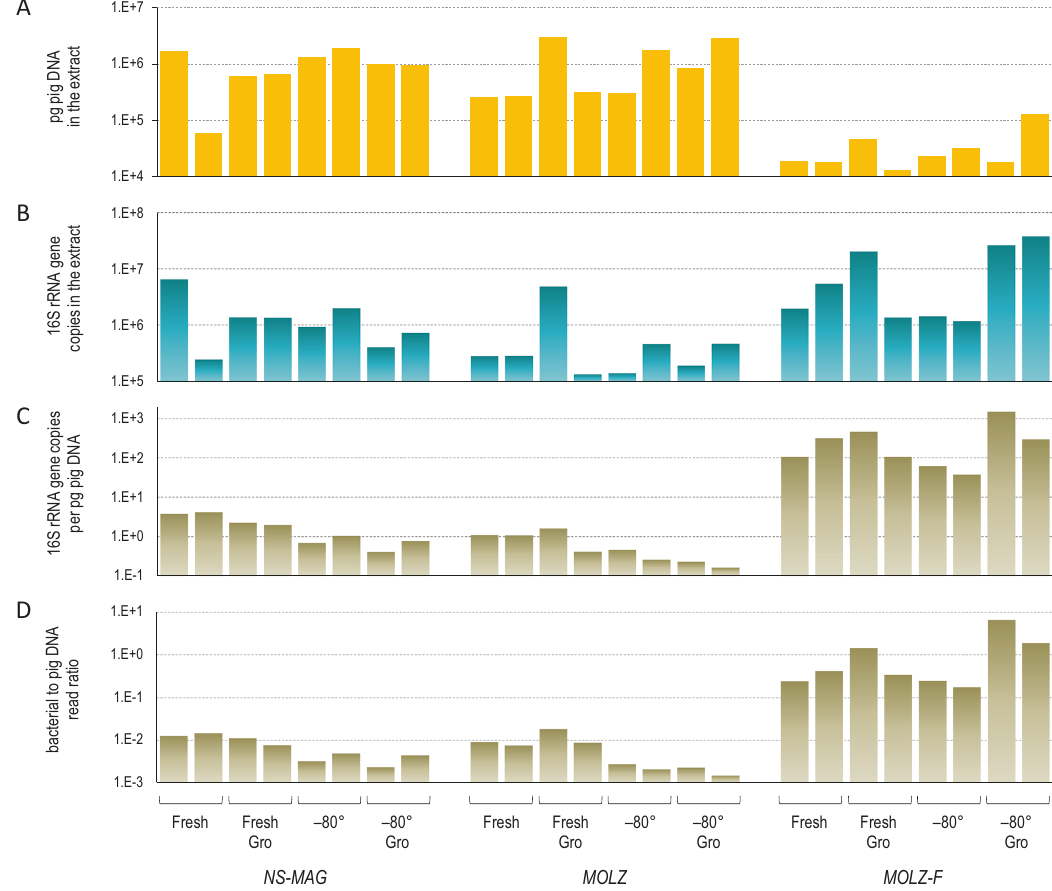
Fig. 1 Quanti fi cation of pig and bacterial DNA in NS-MAG , MOLZ and MOLZ-F extracts obtained from samples following four storage conditions. A Pig DNA quanti fi ed by qPCR. B Bacterial 16S rRNA gene copy number quanti fi ed by qPCR. C Bacterial 16S rRNA gene copy number (as in B ) normalized per pig DNA mass (as in A ). D Ratio of bacterial-to-pig sequencing reads in the mNGS dataset. The number of read pairs corresponding to pig genome was identi fi ed by CLARK. For bacteria, we calculated the average for the number of forward and reverse reads mapped by USEARCH to genome sequence assemblies of the four mock-community alignment-based approach (Fig. 3) but some drawbacks of the k-mer based fast-processing were identi fi ed. A substantial fraction of reads in NS-MAG and MOLZ samples was assigned to species different from those that constituted the mock community, notably Nesterenkonia natronophila (phylum Actinobacteria) (Sup- plementary Fig. 1). Closer inspection of these reads revealed their origin from porcine satellite DNA that were not fi ltered out during the in silico removal of host-derived reads, a situation resembling recently reported misclassi fi cation of bovine satellite DNA as mycobacterial [32].